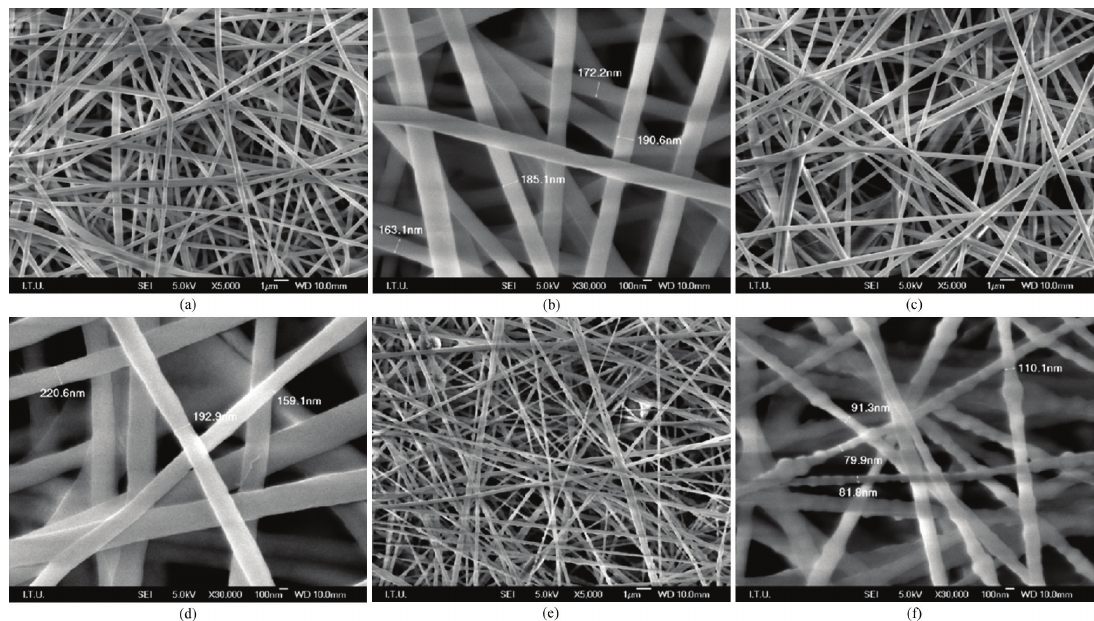
Figure 3. SEM images of (a) and (b) pure PVA nanofiber; (c) and (d) PVA/SiO